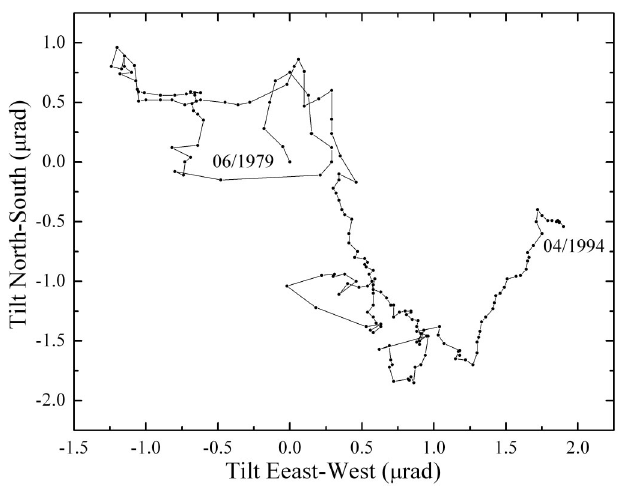
FIG. 27. Secular tilting motion measured at the Esashi station in 1979–1994 (from Ref [39], original data records courtesy of Professor Shigeryu Takeda of KEK, Japan).